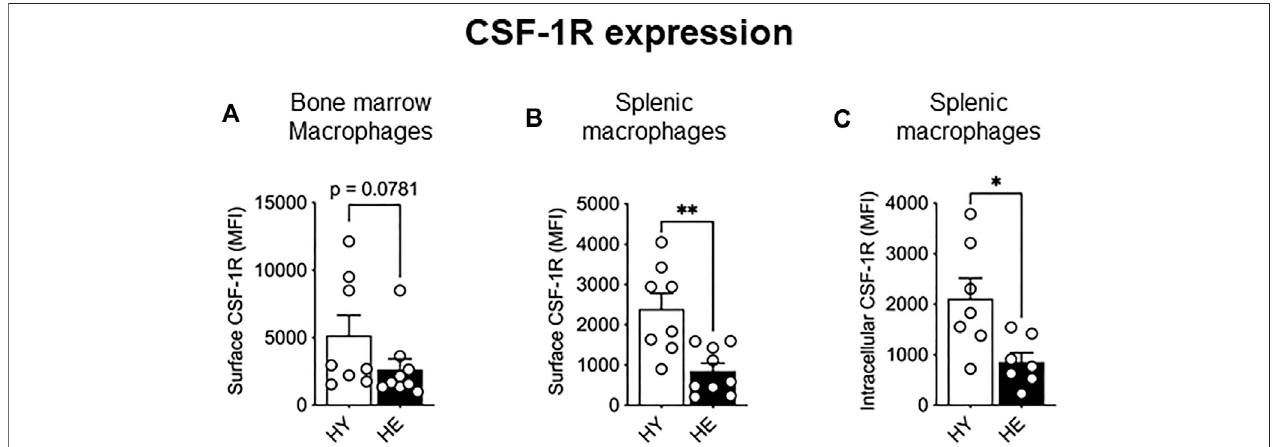
FIGURE 2 | CSF-1R expression decreased in splenic macrophages with healthy aging. CD11b + F4/80 + Ly6G neg macrophage CSF-1R surface expression in the bone marrow (A) and spleen (B) and intracellular CSF-1R expression in the spleen (C) shown as median fl uorescence intensity (MFI). HY — healthy young, HE, healthy elderly. Data shown as mean ± SEM; n = 7 – 8 mice/group; * p < 0.05, ** p <